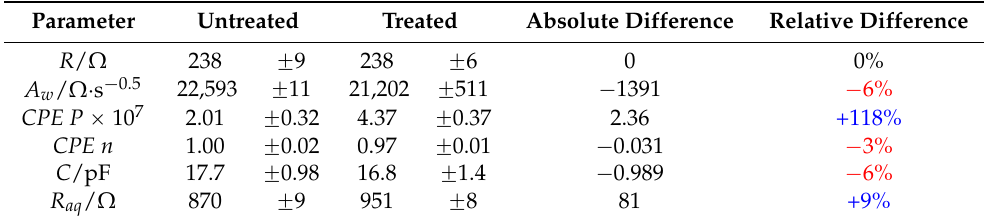
Table 2. Parameter fit for Figure 11, case a . The errors represent the quality of the fit for each element. Blue and red font colours are used to highlight an increasing or decreasing trend, respectively. Parameter Untreated Treated Absolute Difference Relative Difference R / Ω A w / Ω ¨ s ´ 0.5 22,593